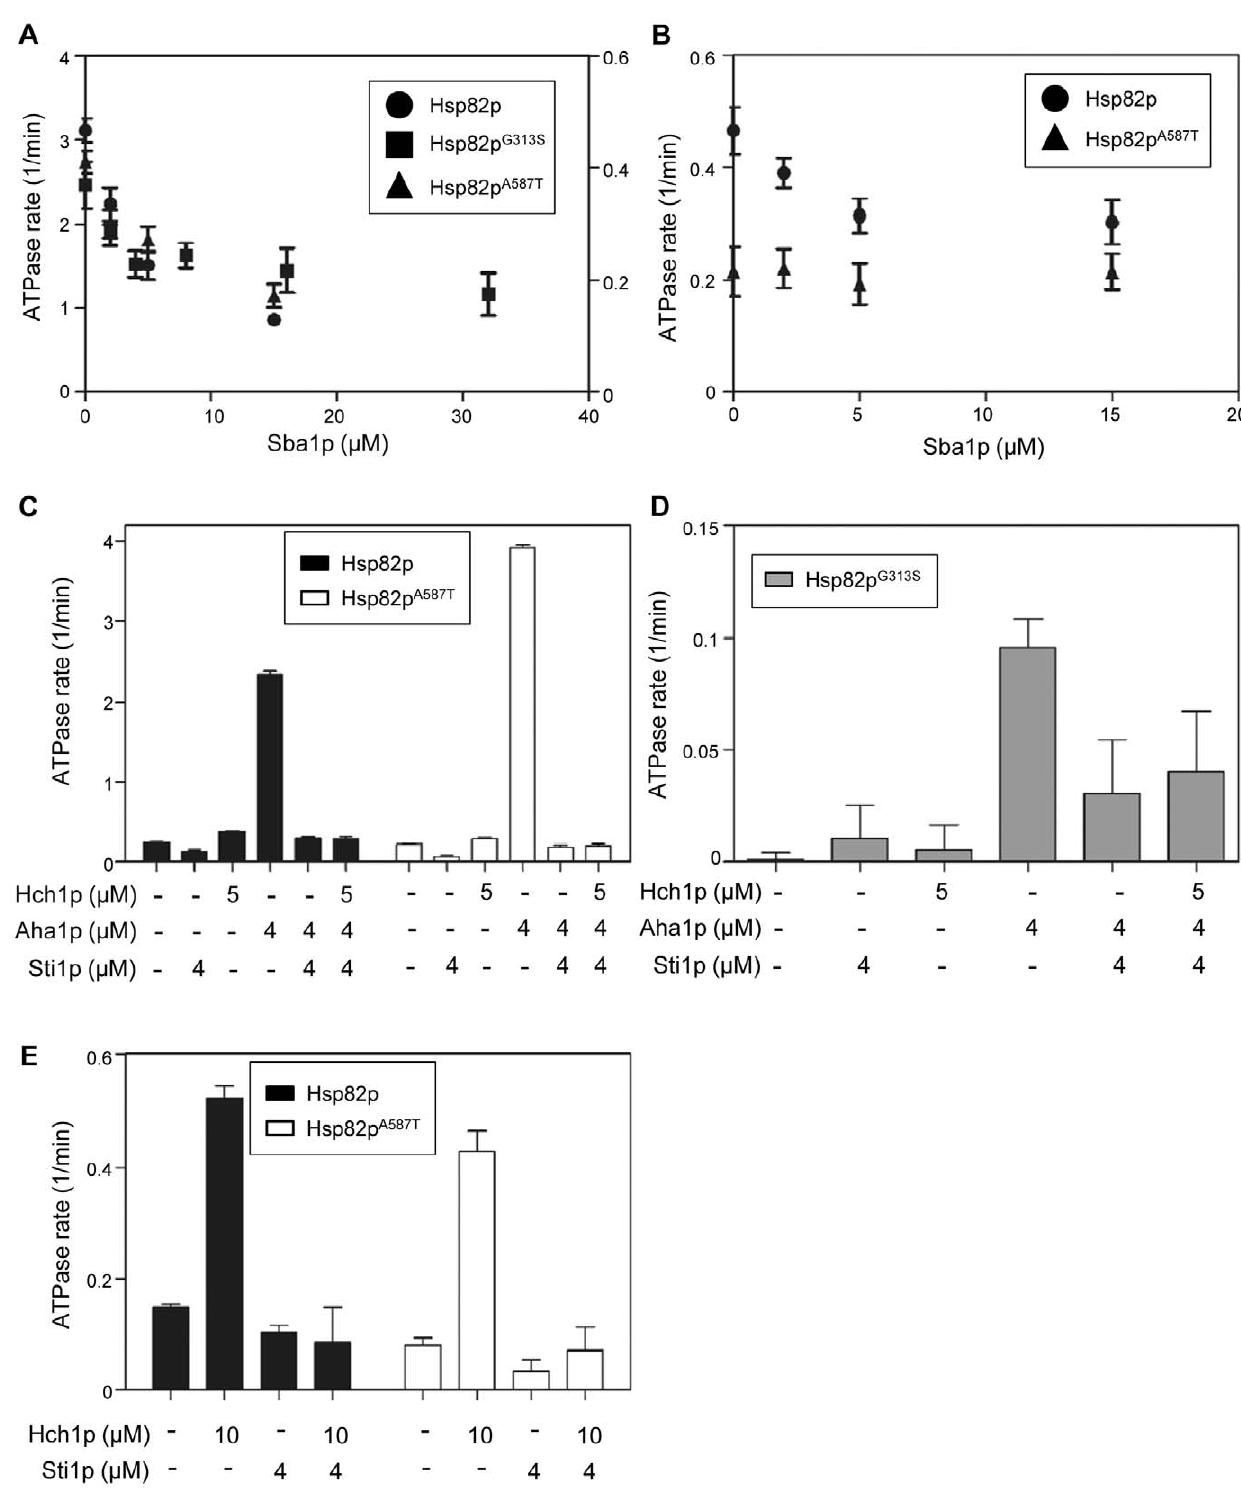
Figure 6. Inhibition of Aha1p-stimulated ATPase activity of Hsp82p, Hsp82p G313S and Hsp82p A587T . A. Inhibition of Aha1p-stimulated ATPase activity of wildtype Hsp82p (circles), Hsp82p G313S (squares), and Hsp82p A587T (triangles) by increasing concentrations of Sba1p. ATPase rate for wildtype Hsp82p and Hsp82p A587T shown on left axis (Reactions contained 2 m M Hsp82p, 10 m M Aha1p and indicated concentrations of Sba1p). ATPase rate for Hsp82p G313S shown on right axis (reactions contained 5 m M Hsp82p, 10 m M Aha1p and indicated concentrations of Sba1p). B. Inhibition of Hch1p-stimulated ATPase activity of wildtype Hsp82p (circles), and Hsp82p A587T (triangles) by increasing concentrations of Sba1p. Reactions contained 2 m M Hsp82p, 10 m M Hch1p and indicated concentrations of Sba1p. C. Inhibition of Aha1p-stimulated ATPase activity of wildtype Hsp82p (black bars) and Hsp82p A587T (white bars) by Sti1p. All reactions contained 2 m M Hsp82p and indicated concentrations of co- chaperones. D. Inhibition of Aha1p-stimulated ATPase activity of Hsp82p G313S (grey bars) by Sti1p. All reactions contained 2 m M Hsp82p and indicated